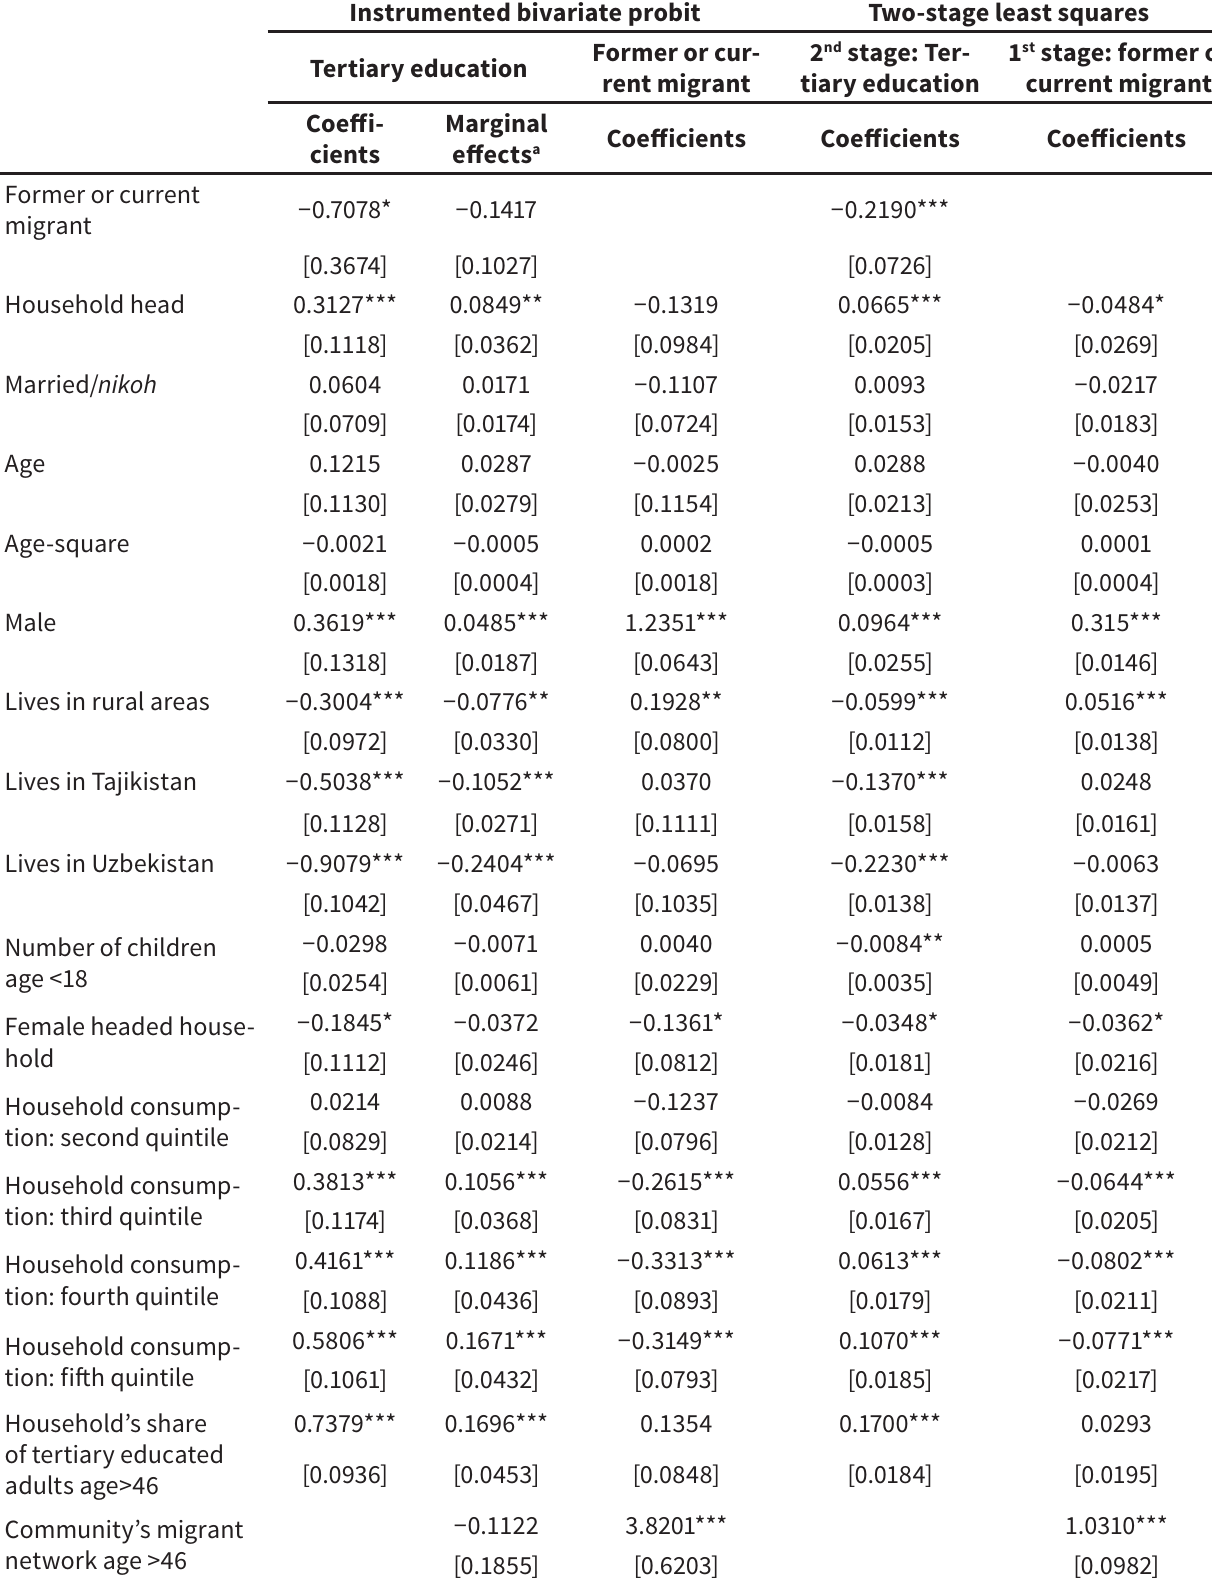
Instrumented bivariate probit and two-stage least squares IV regressions on choices of migration